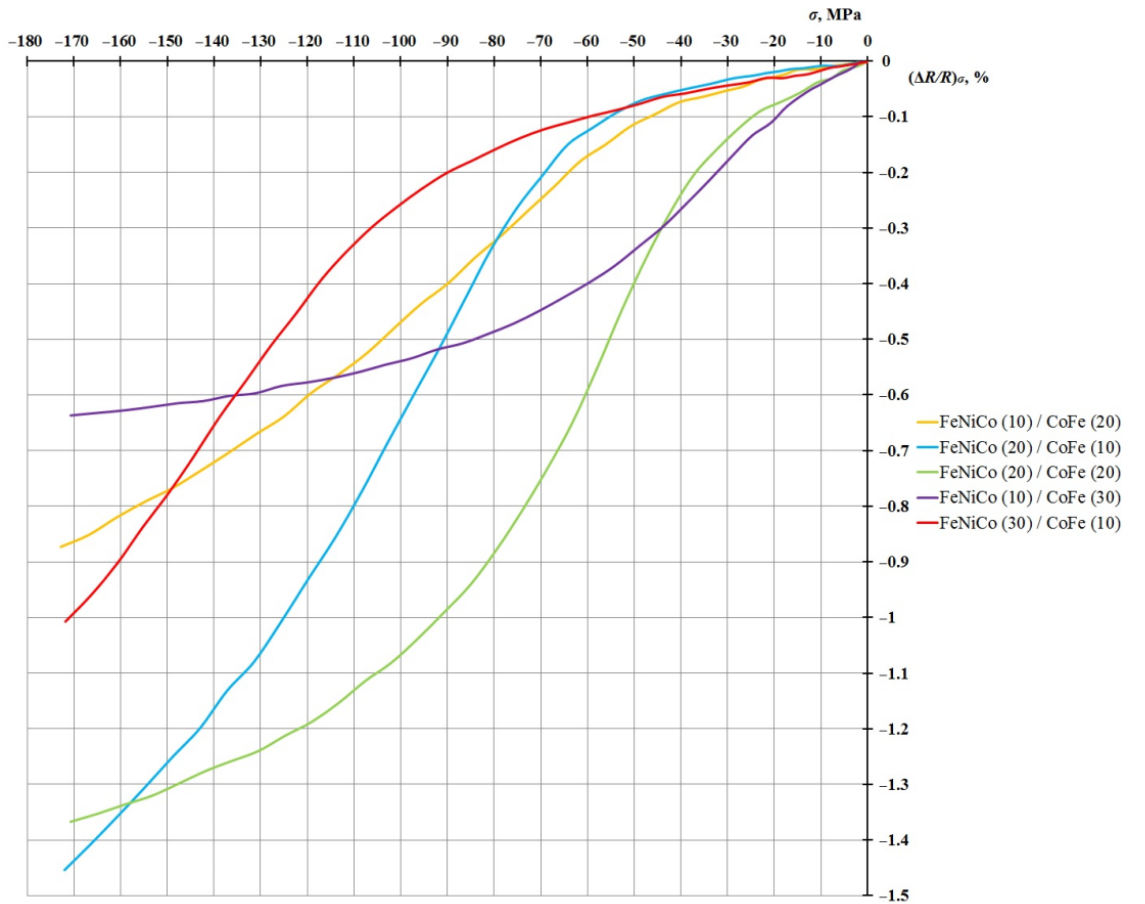
Figure 5. Dependence of the value of the relative change in the resistance due to the load ( ∆ R/R ) σ on the value of mechanical load σ for nanostructures of the FeNiCo/CoFe type (layer thickness in nm).